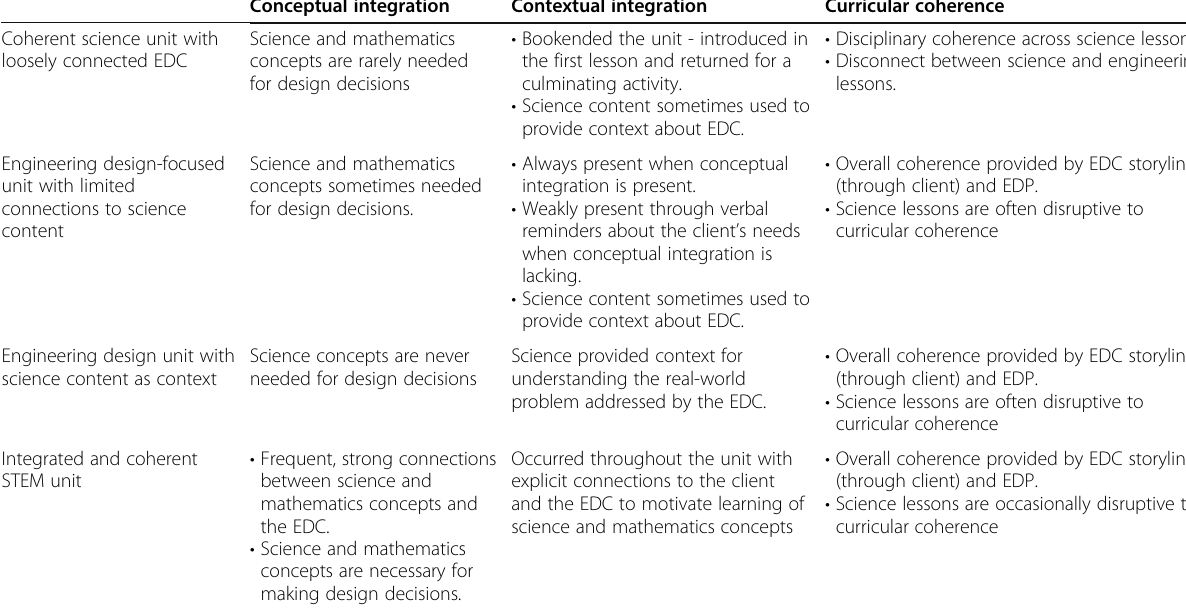
Table 5 Summary of nature of integration and curricular coherence by CFG category Conceptual